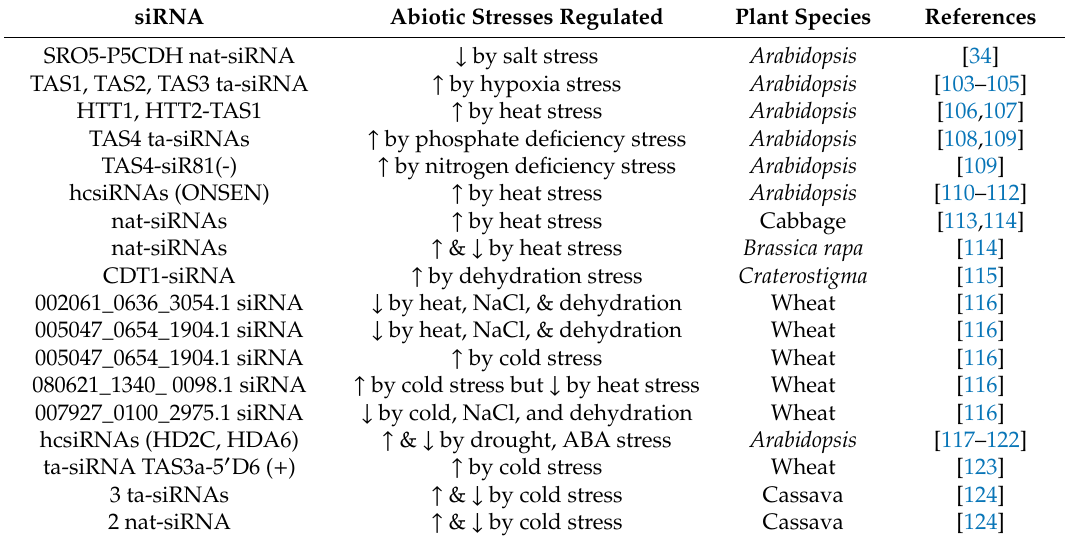
Table 1. Examples of siRNAs associated with Abiotic stress response in